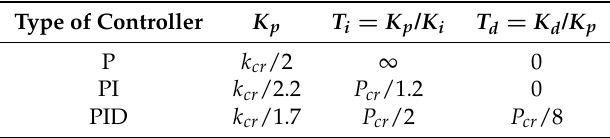
Table 2. Ziegler–Nichols tuning